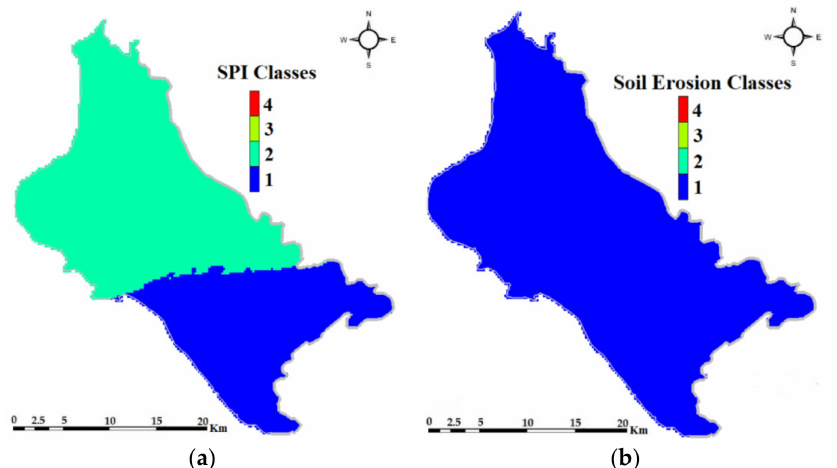
Figure 4. Maps of aquifer indicating the spatially distributed classes of: ( a ) Standardized Precipitation Index for November 2011, ( b ) Soil erosion for the period 2001–2012.